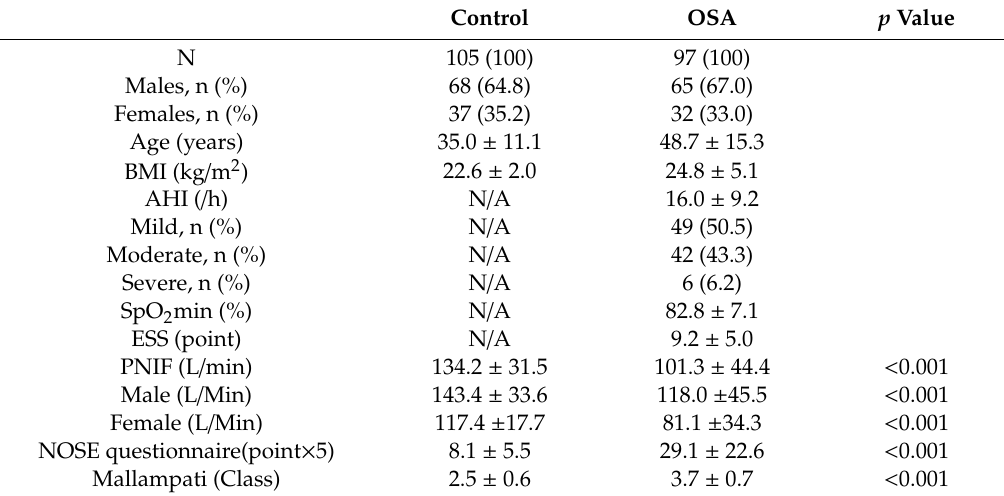
Table 1. The characteristics of OSA patients and